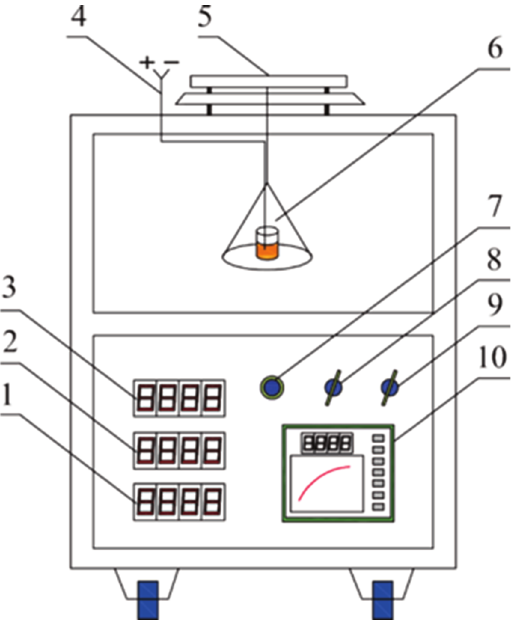
Figure 1: Schematic of a microwavedryingsystem1 – powercontroller; 2 – ampere meter; 3 – voltmeter; 4 – thermocouple; 5 – electronic balance; 6 – materials; 7 – power switch; 8 – start switch; 9 – stop switch; 10 – computer